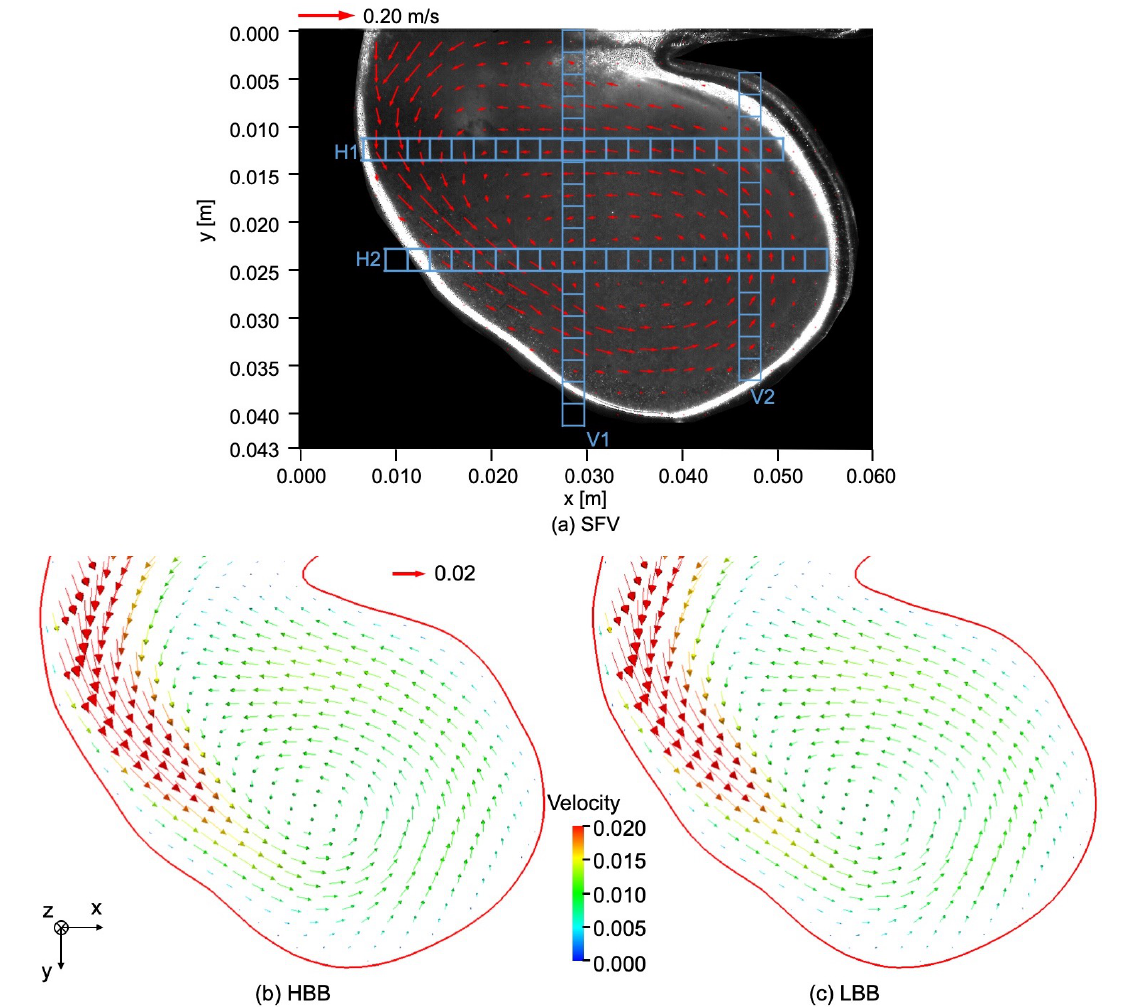
Figure 7. Comparison of velocity fields between ( a ) SFV, ( b ) HBB and ( c )